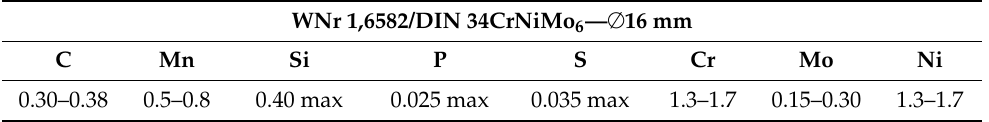
Table 1. Chemical composition of tool